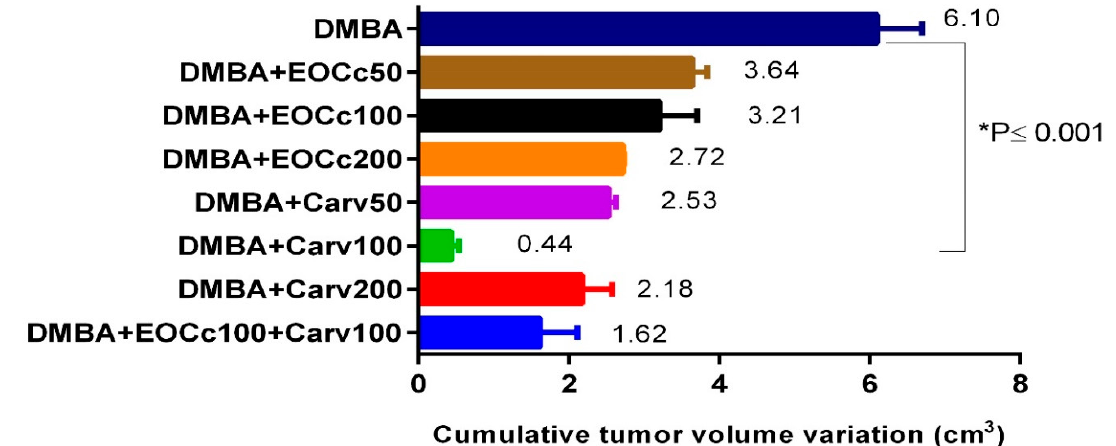
Figure 3. Variation of the cumulative tumor volume as a result of treatment with EOCc and carvacrol in breast carcinogenesis induced by DMBA in rats. * Significant difference from the DMBA group ( p < 0.001). One-way ANOVA followed by a post hoc Tukey test.